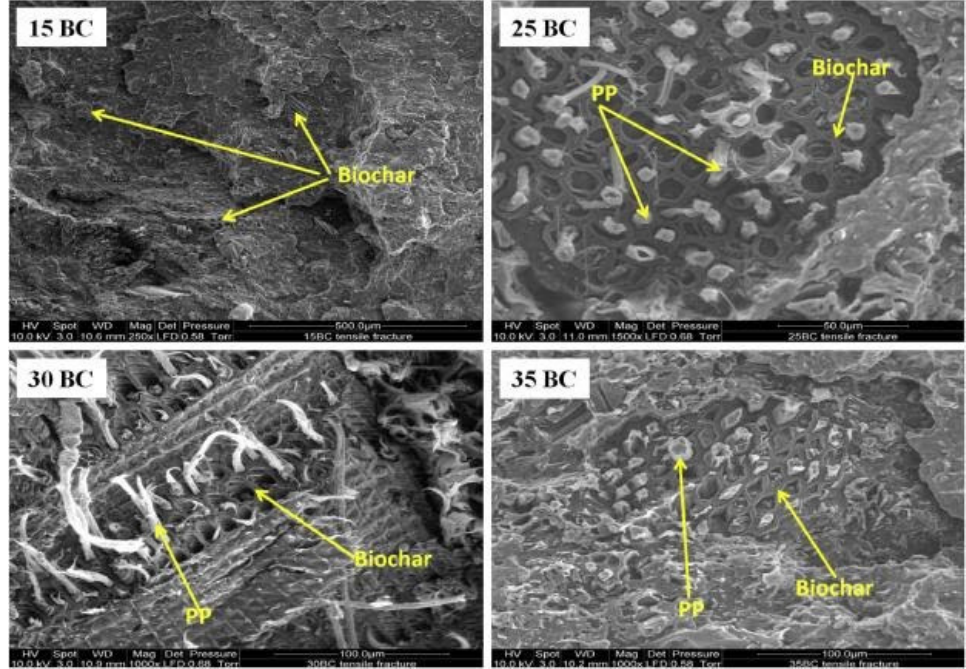
Figure 1. SEM micrographs of PP/BC composites containing different amounts of filler [44]. Reproduced with permission from Elsevier Science Ltd. 2016, Elsevier Science, Ltd.